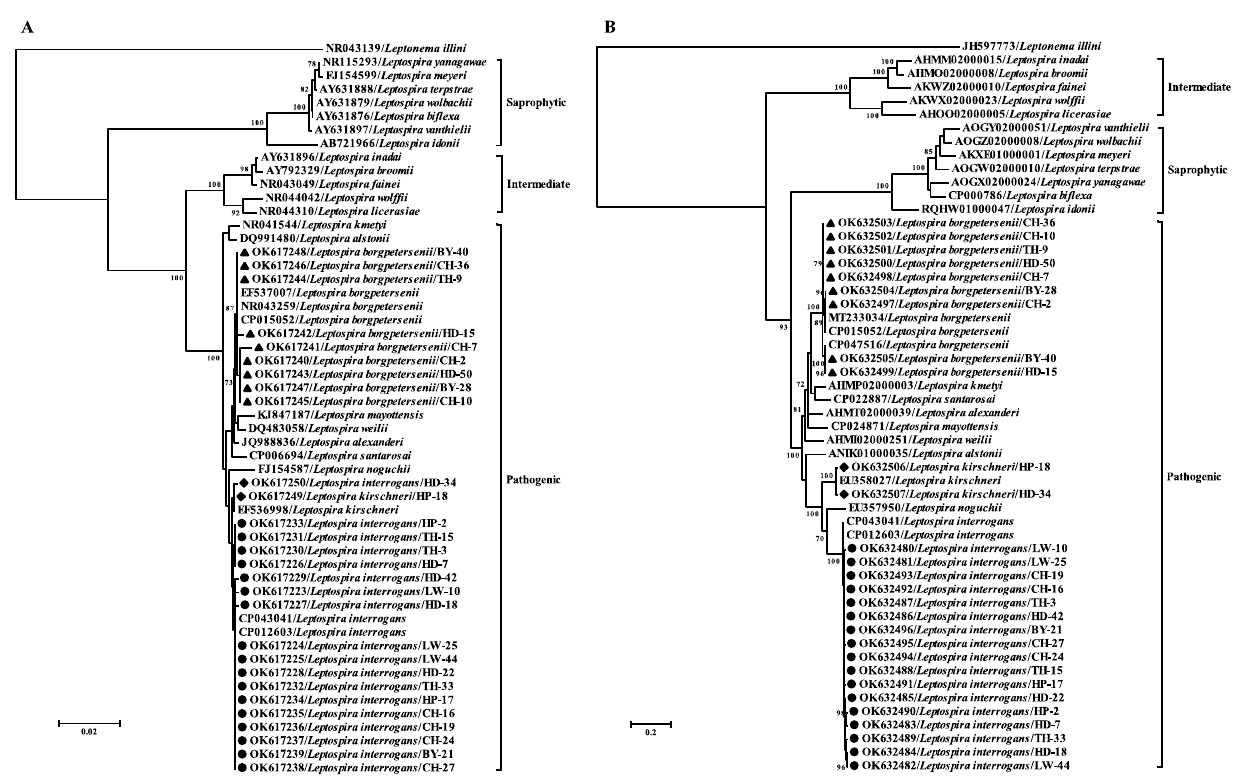
Figure 2. Maximum-likelihood phylogenetic trees based on the nucleotide sequences of ( A ) rrs and ( B ) secY gene of pathogenic Leptospira . Bootstrap values were calculated with 1000 replicates of the alignment, and only bootstrap values >70% are shown at appropriate nodes. The trees were mid-point rooted for clarity only, and corresponding sequences of Leptonema illini were used as the ourgroup. Sequences of Leptospira determined in this study are shown with different labels. Table 3. Distribution of pathogenic Leptospira species among